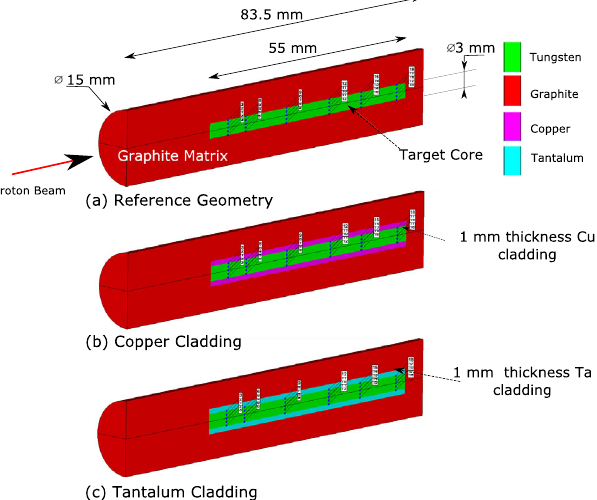
FIG. 3. Half-view geometry of the different configurations studied in the present work: (a) W target surrounded by graphite matrix (b) W target with Cu cladding surrounded by graphite matrix (c) W target with Ta cladding surrounded by graphite matrix.